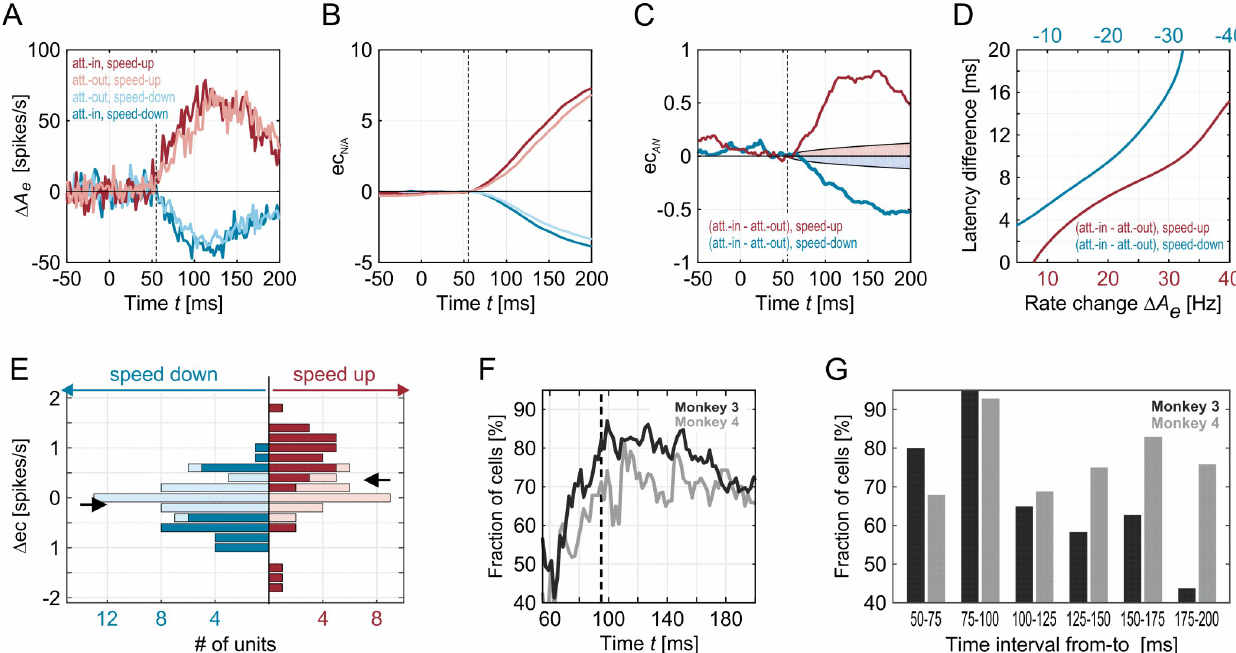
Fig 6. Quantification of attention-induced rate changes. (A) Population average of speed change-induced rate modulations for the four attentional conditions. Data taken from M3. (B) Corresponding excess cumulative spike counts relative to the pre-change firing rate. (C) Attention-induced differences in excess cumulative spike count, separately for accelerations (red) and decelerations (blue). Differences are significantly larger than 0 ( p < 0.01) outside shaded regions. (D) Time advantage (i.e. latency difference) induced by attention for different read-out thresholds (i.e. absolute rate changes Δ A measured in the experimental data shown in (A–C). (E) Histogram of attention-induced differences in excess cumulative spike count over individual sites, separately for acceleration and deceleration conditions. Dark colors indicate samples with values being significantly different from zero. Samples were taken at 95 ms after stimulus change. (F) Percentage of significantly modulated individual units for which cumulative counts were significantly larger with attention in the speed-up condition or significantly smaller with attention in the speed-down condition. Black line, M3; gray line, M4. Dashed line indicates the time for which the samples for the histogram in panel (E) were taken. (G) Percentage of significantly modulated units for which spike count differences between activities before and after the stimulus change were significantly larger in the speed-up condition or significantly lower in the speed-down condition, separately for successive time intervals of 25 ms